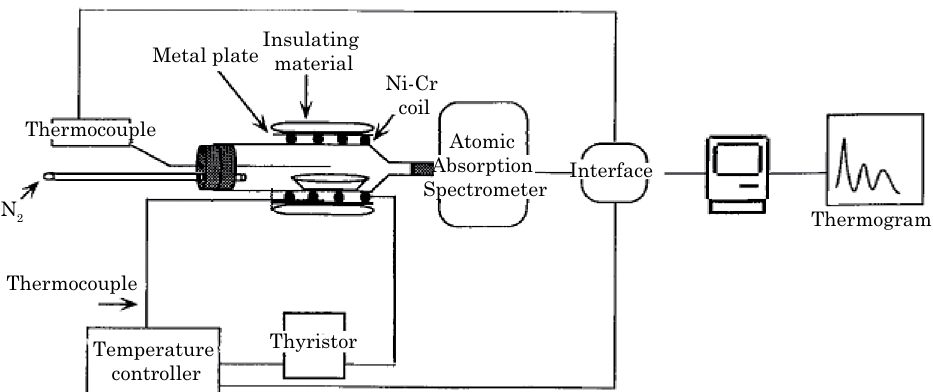
figure 1. Schematic of equipment used for mercury thermal desorption of solid matrices by atomic absorption. adapted from Windmöller